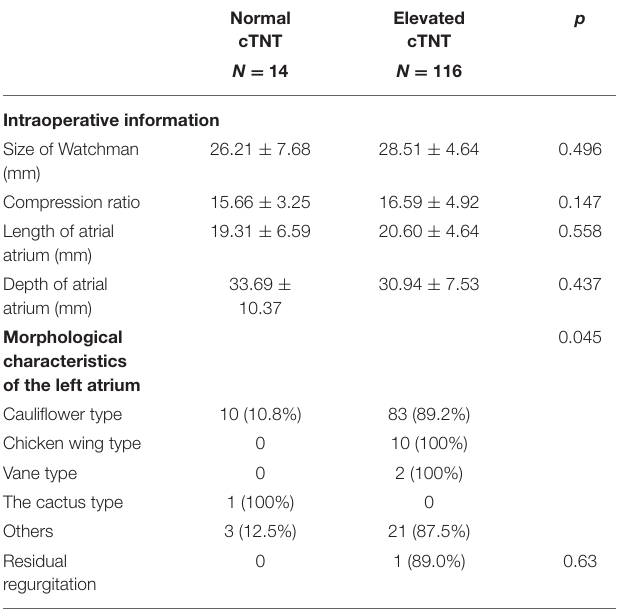
TABLE 3 | Information of the Watchman group.